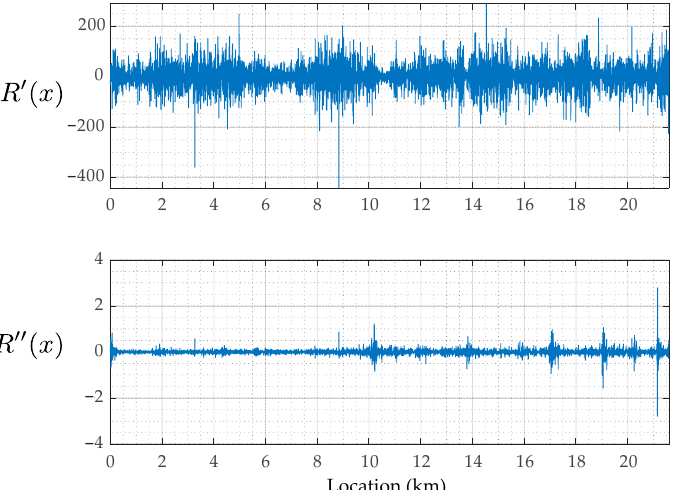
(cid:0) c (cid:1) ) = 5. = 2 and ( k m m (cid:4673) = 2 and (cid:4672) (cid:3038) (cid:4673) = (cid:3040) (cid:3040) 16 of 19